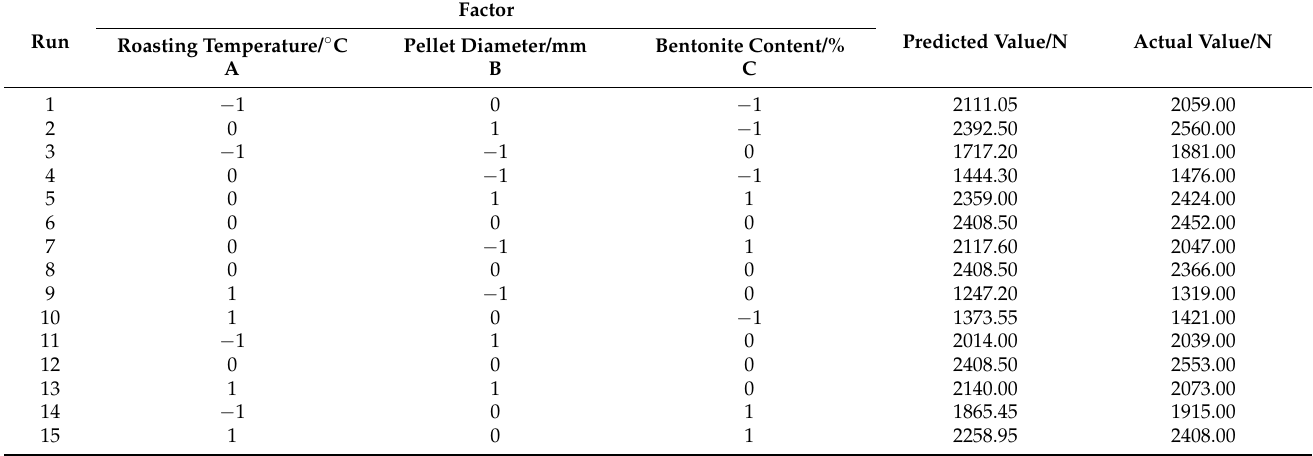
Table 5. Experimental